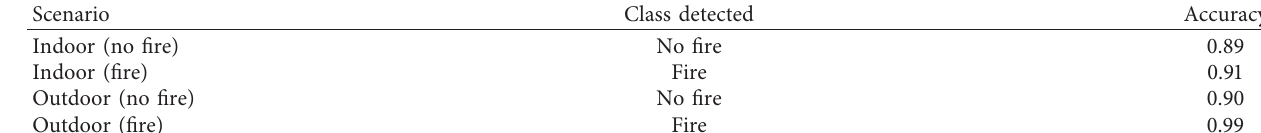
Figure 15: (a, b) Screenshots from the video classifier test. Table 6: Video output results for the fire detection and classification.